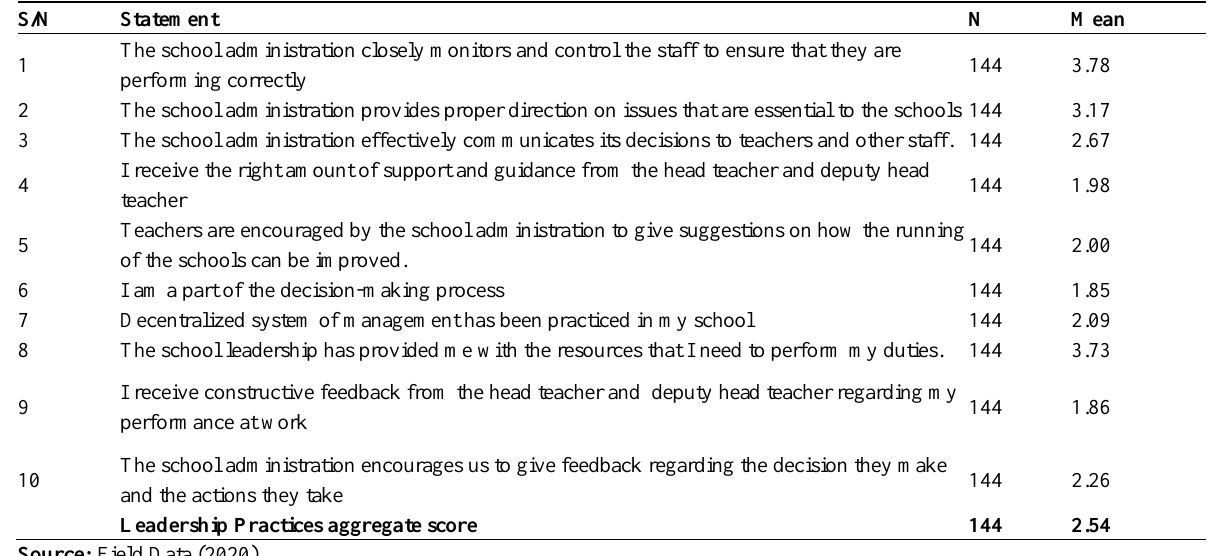
Table 5: Leadership Practices in Private Primary Schools in Rongai